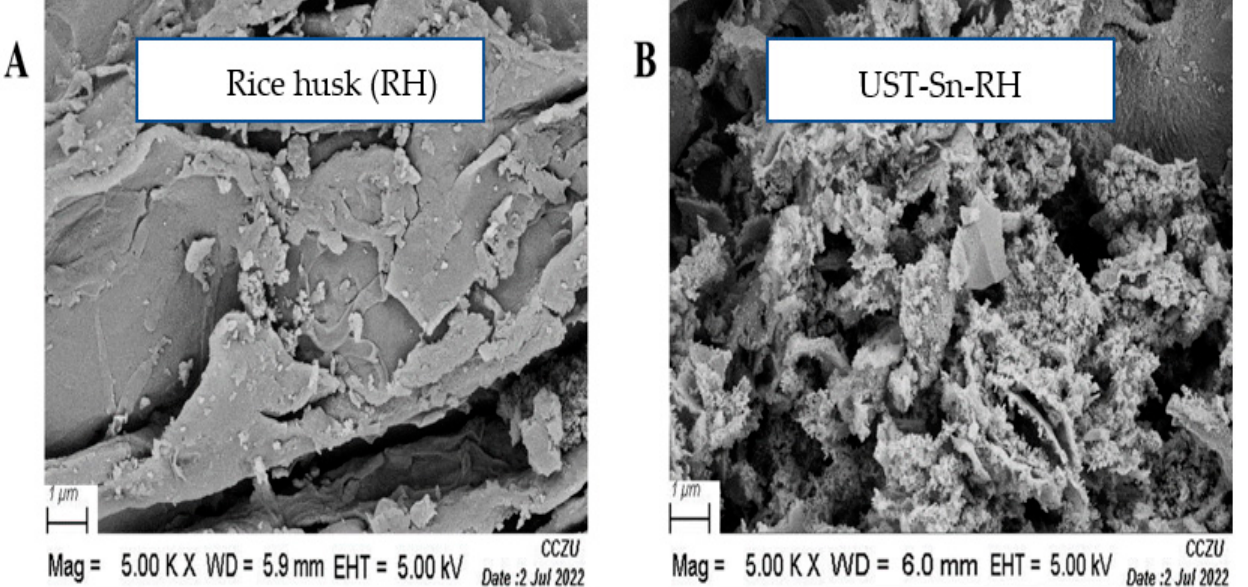
Figure 2. Scanning Electron Microscopy (SEM) images of rice husk (RH) ( A ) and chemocatalyst UST-Sn-RH ( B ).